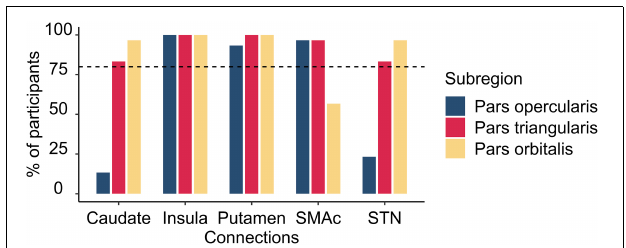
FIGURE 4 | Histogram illustrating the percentage of participants having connections from the rIFG subregions to the regions within the stopping network. The vertical dashed line refers to the inclusion threshold of 80% for a reliable connection. SMAc, supplementary motor area complex; STN, subthalamic